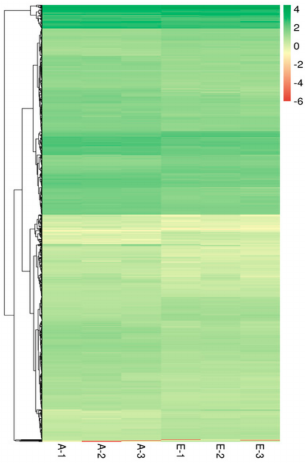
Figure 6. The cluster analysis of differentially expressed